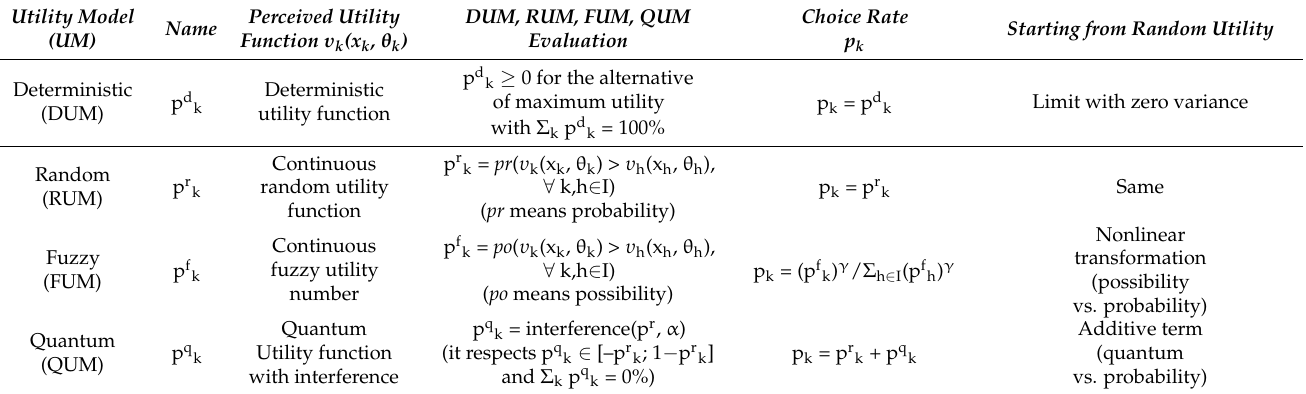
Table 1. Comparison between the characteristics of the utility